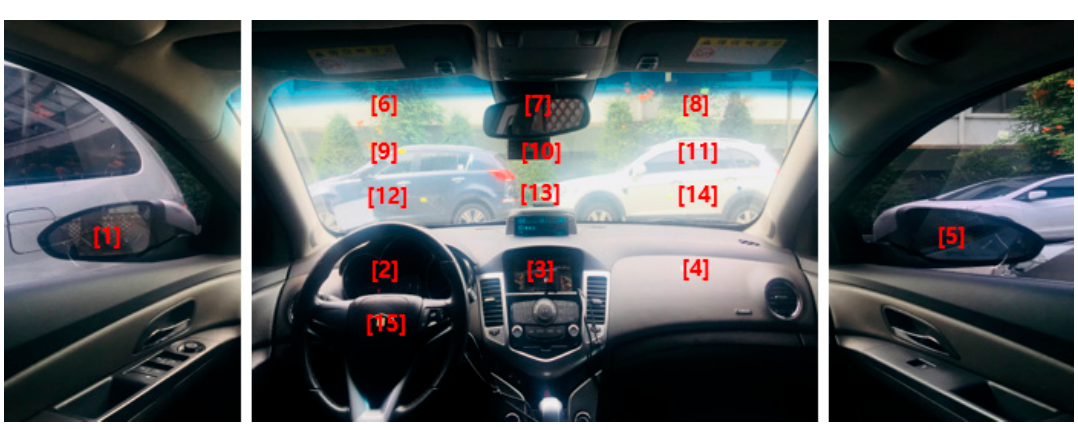
Figure 10. 15 gaze zones in our experiments.